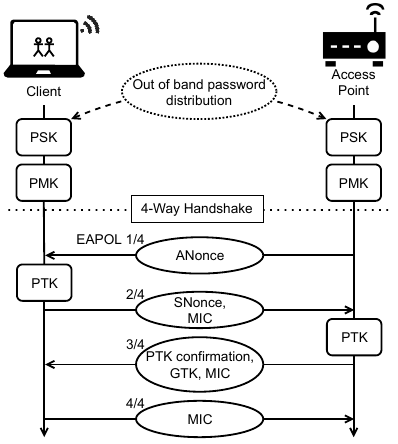
Figure 1. The 4-way